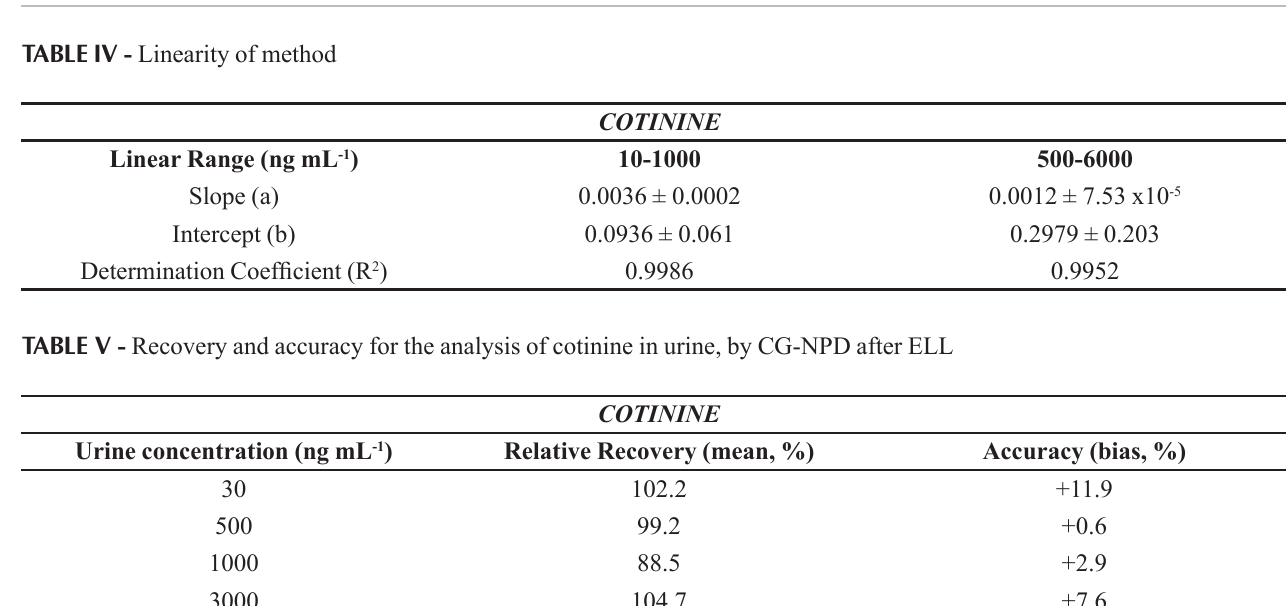
TABLE IV - Linearity of method